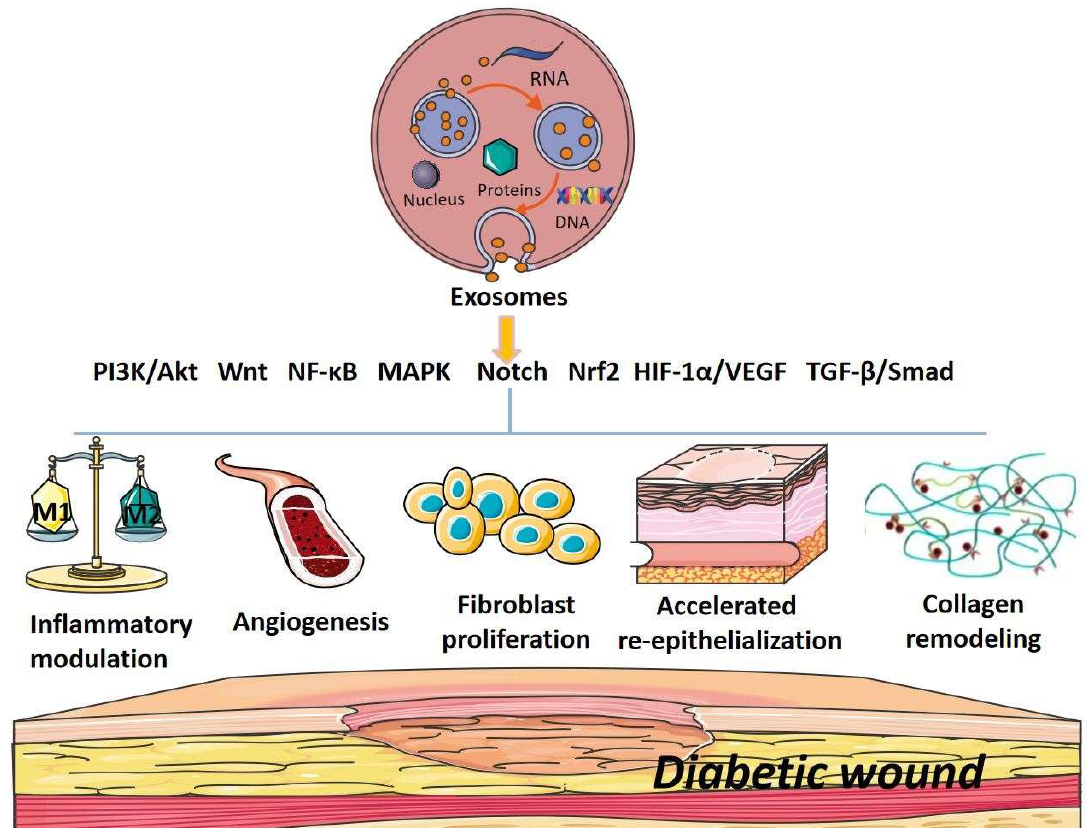
Figure 2. A schematic diagram showing that exosomes can modulate signaling pathways, including PI3K/Akt, Wnt, NF-κB, MAPK, Notch, Nrf2, HIF-1α/VEGF and TGF-β/Smad, to promote diabetic wound healing through the regulation of inflammatory responses, down-regulation of oxidative stress, promotion of angiogenesis and fibroblast proliferation, inducement of re-epithelization and collagen deposition as well as inhibition of scar formation